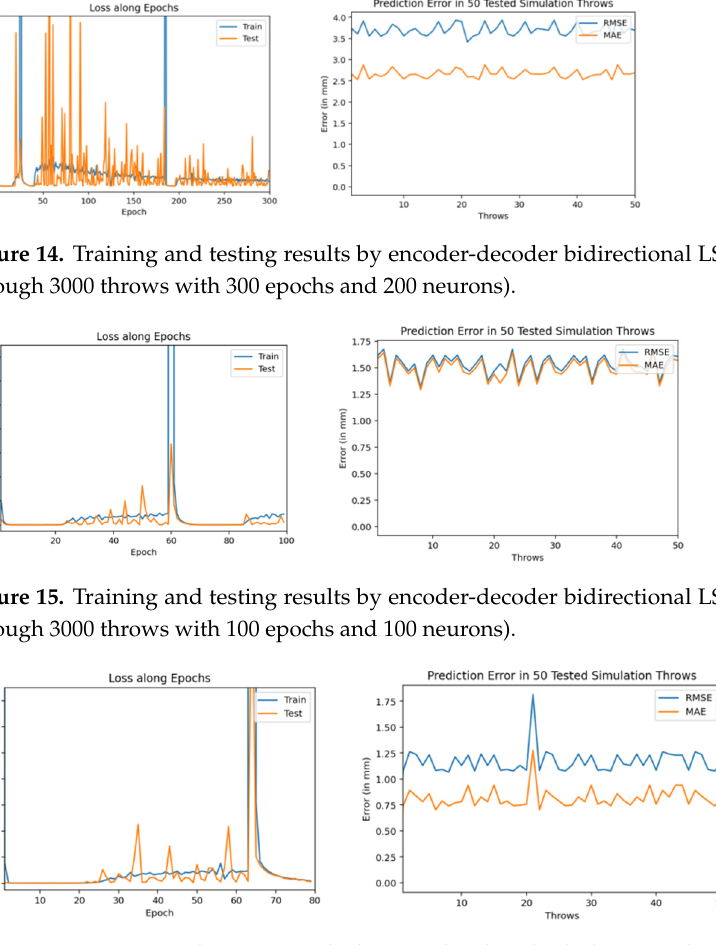
( c ) Figure 17. Prediction error results by applying proposed model for different datasets of test throws.